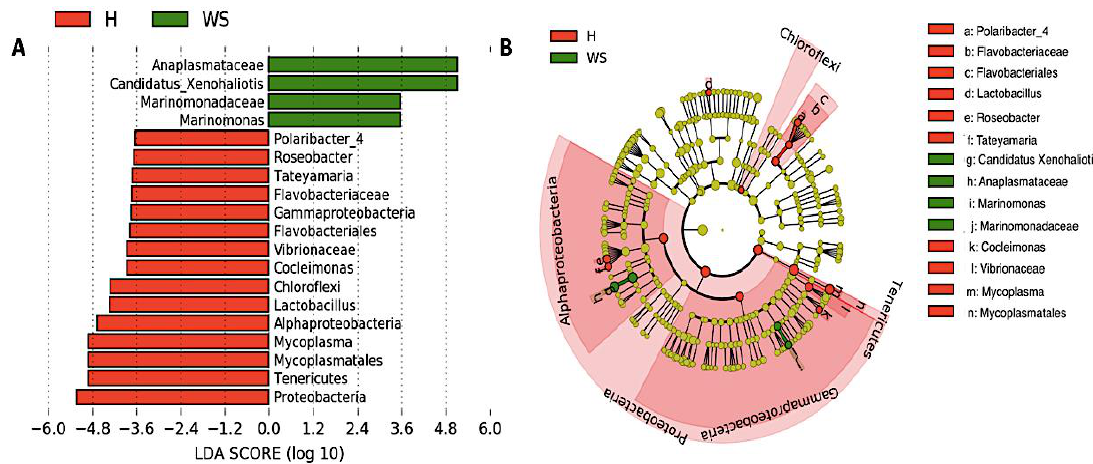
Figure 4. Di ff erences in digestive gland microbiota of healthy red abalones (H) compared with red abalones with withering syndrome disease (WS). Analysis of 16S rRNA reveals the di ff erential composition of microbiota depending on the origin of the sample (H or WS). LEfSe was used to determine the statistical significance and the e ff ect size of the di ff erential abundance of taxa between H and WS. Section ( A ) shows LDA score of abundance of taxa; Section ( B ) shows cladogram showing di ff erentially abundant taxa (phylum to genus) of digestive gland microbiota in healthy red abalones and red abalones with WS